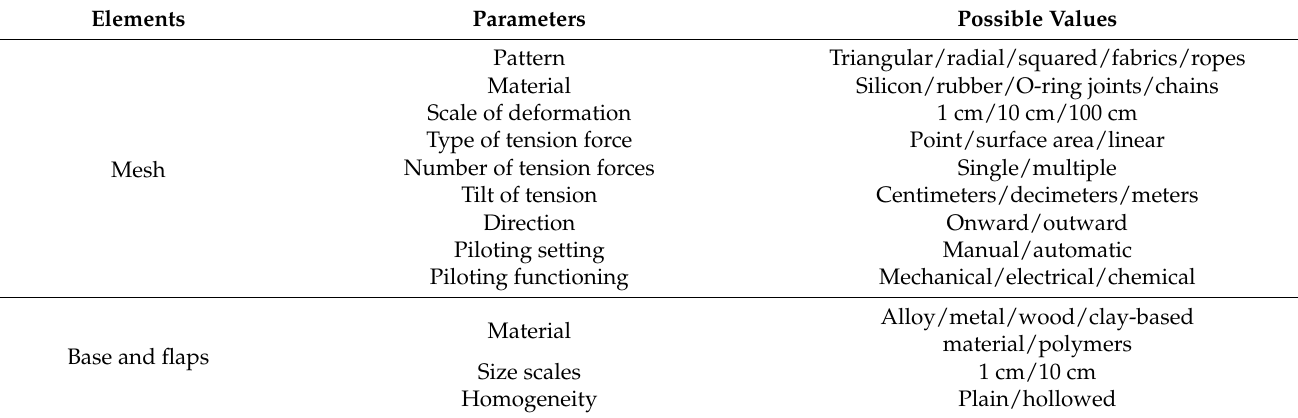
Table 3. List of design parameters that were considered for the concept and their respective possible values.